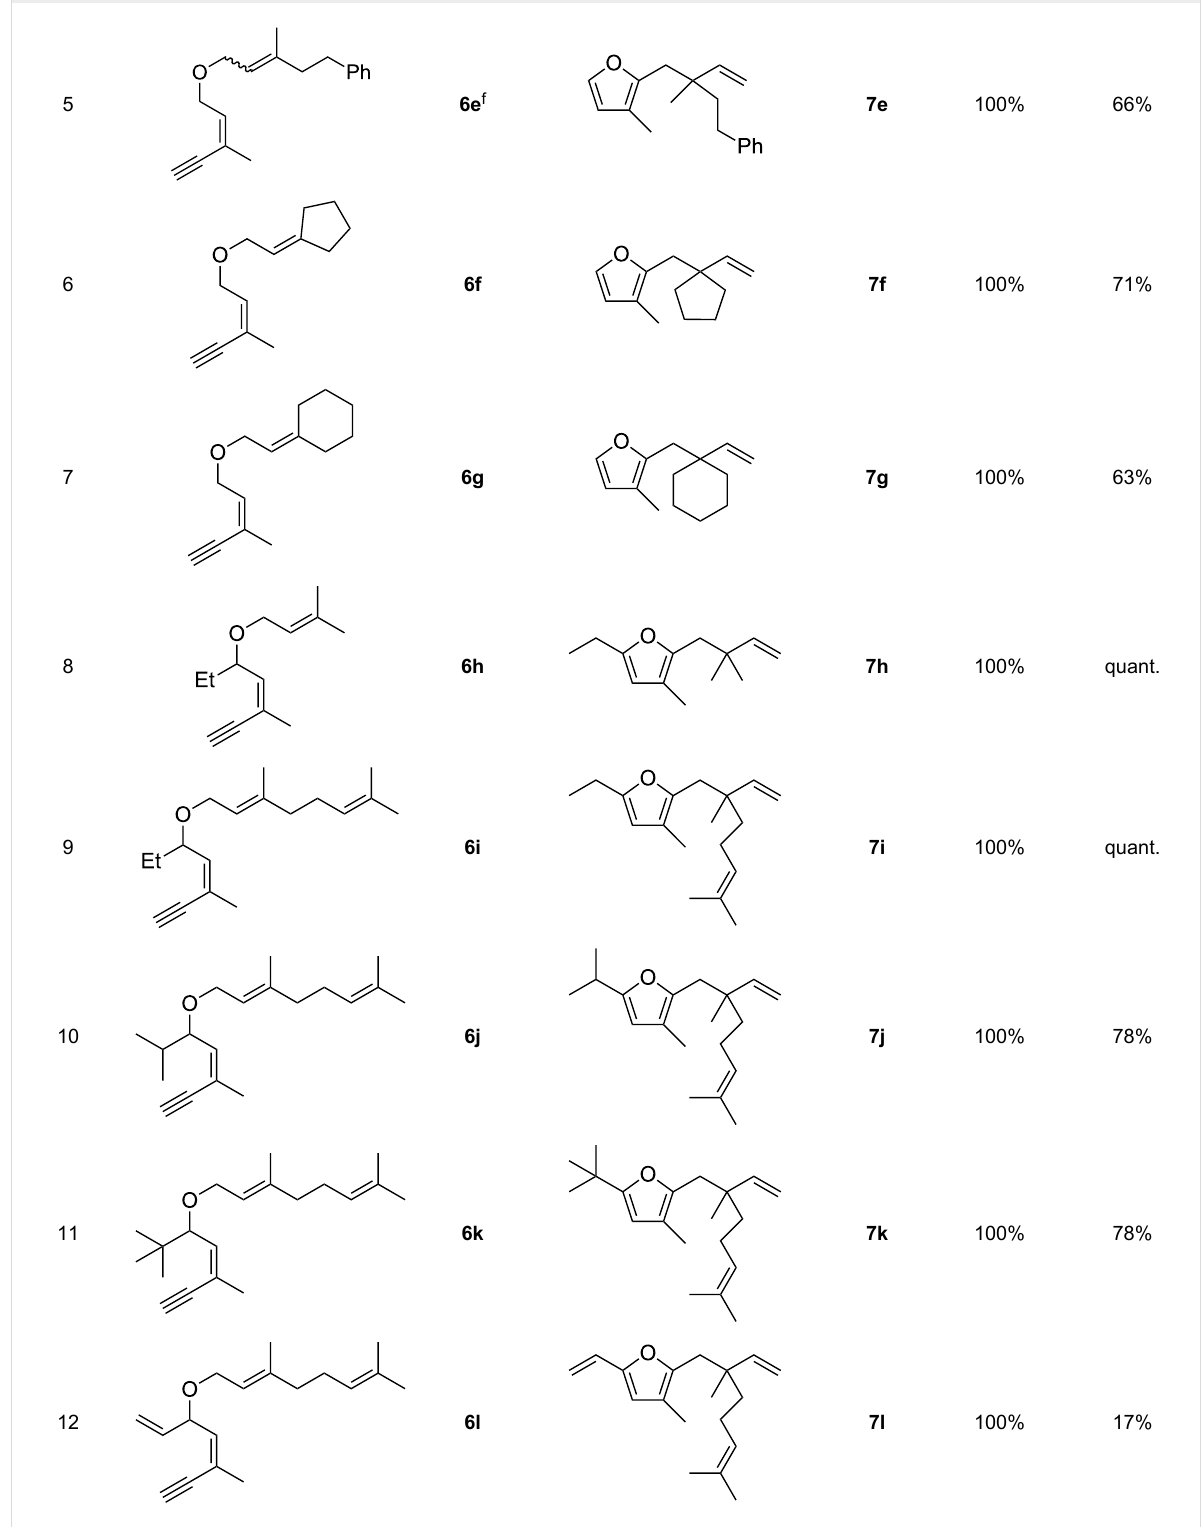
Table 1: Scope of the gold(I)-catalyzed formation of furans. a